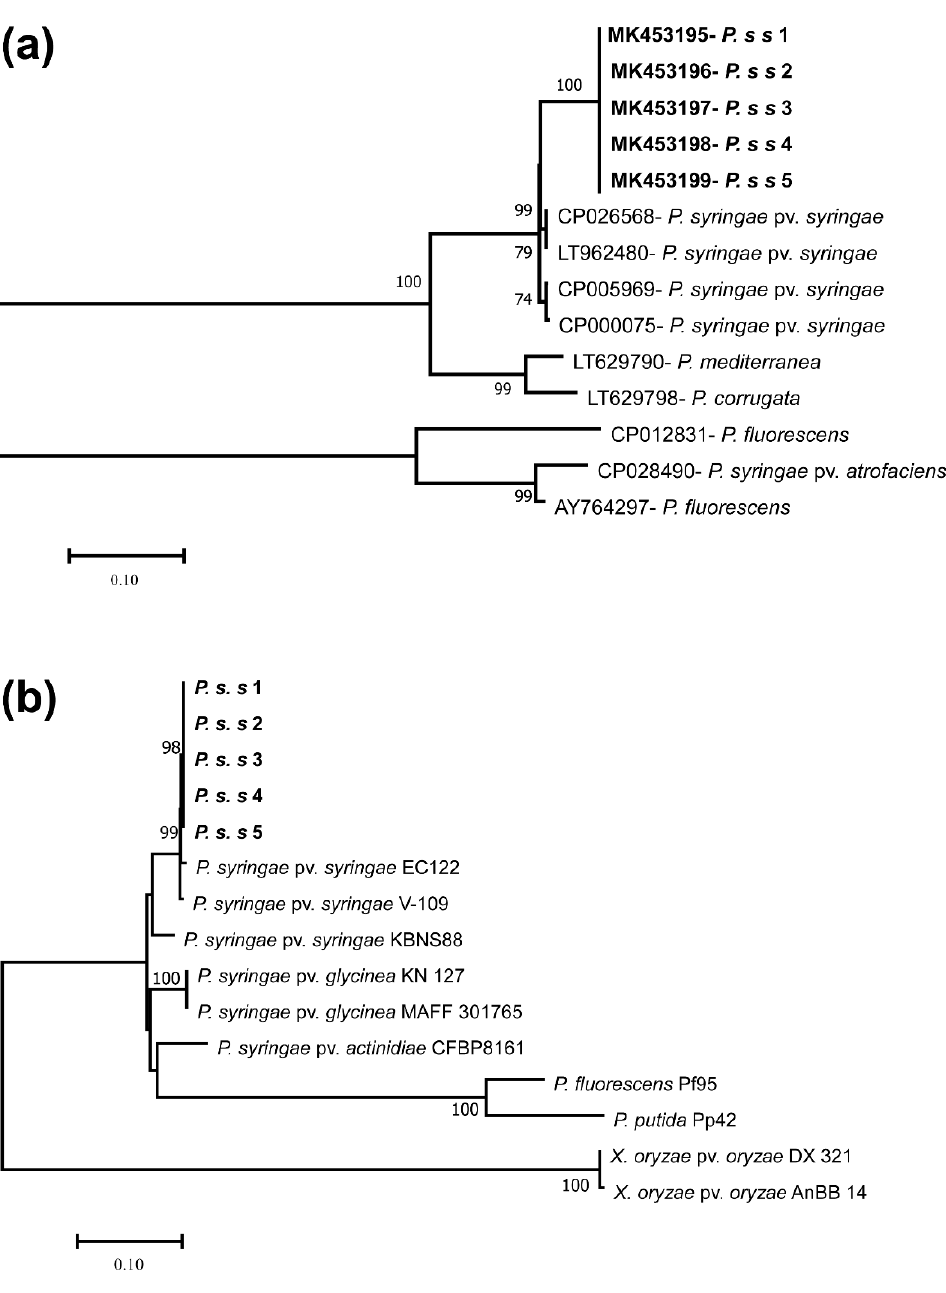
Figure 2. Joining phylogenetic trees neighbor based on syrB ( a ) and 16S rRNA ( b Fig.2 Neighbor-Joining phylogenetic trees based on syrB (a) and concatenated gyrB - rpoD - gltA (b) genes of Pseudomonas spp. The names of Pseudomonas spp. refer to recent changes made in the taxonomy. The P. syringae pv. syringae isolates Pss1 - Pss 5 obtained in this study were indicated in bold.